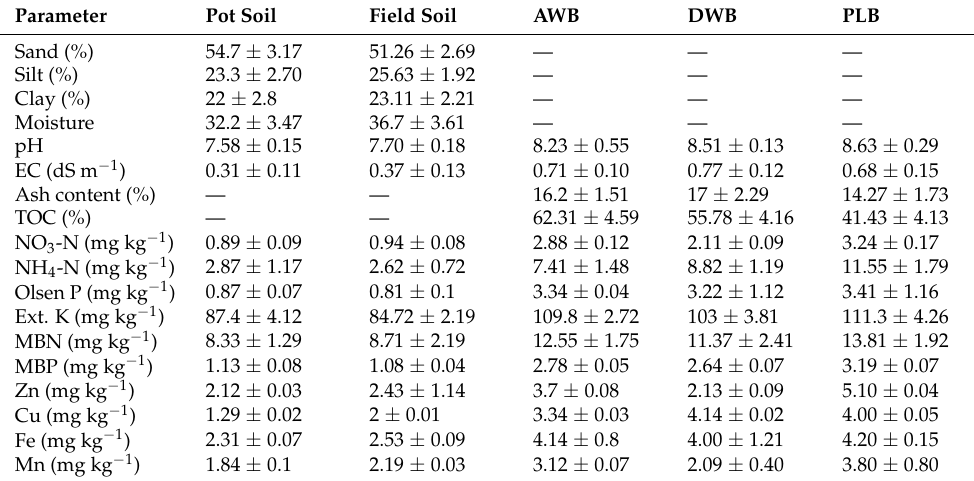
Table 1. The physical, chemical and biological properties of biochars and soils of both experiments. Parameter